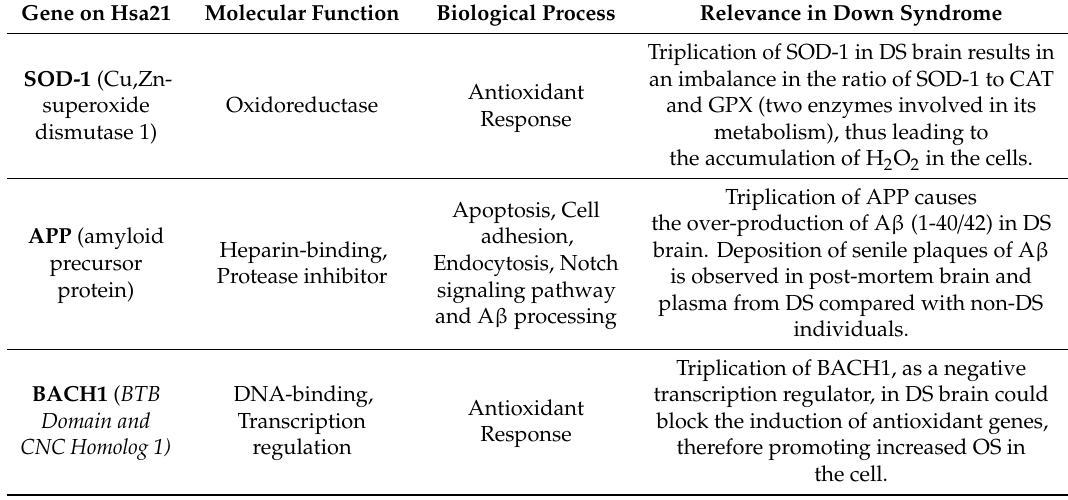
Table 1. List of some genes located on Hsa21 linked to OS, as discussed in the text. Gene on